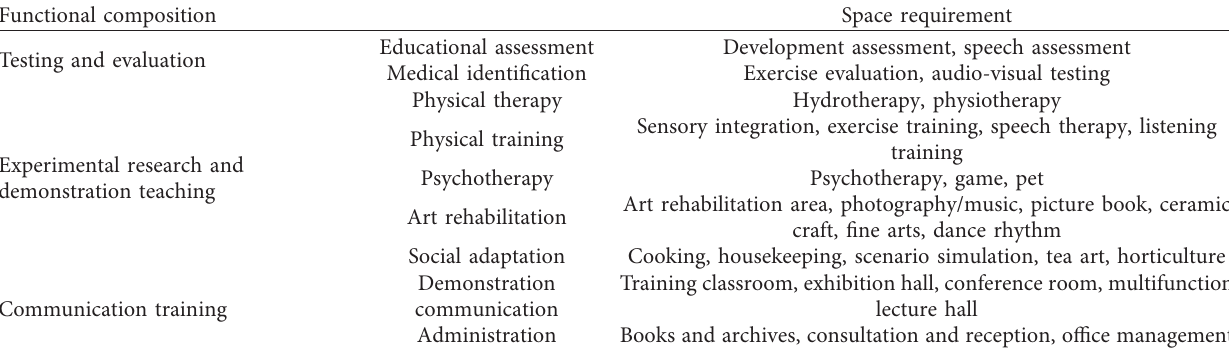
Table 5: Function structure of the resource